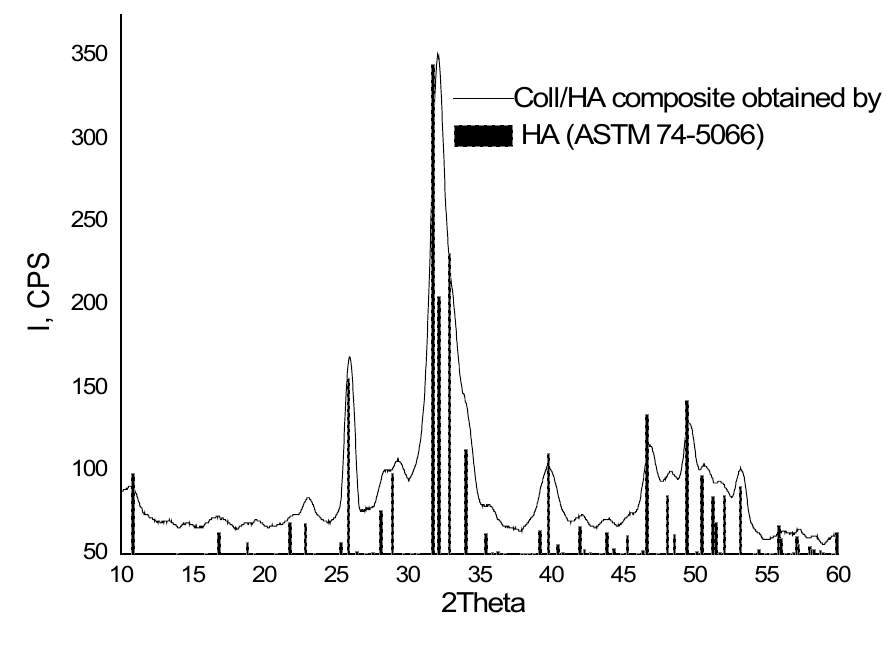
Figure 3. XRD pattern of C3-7 COLL/HA composite